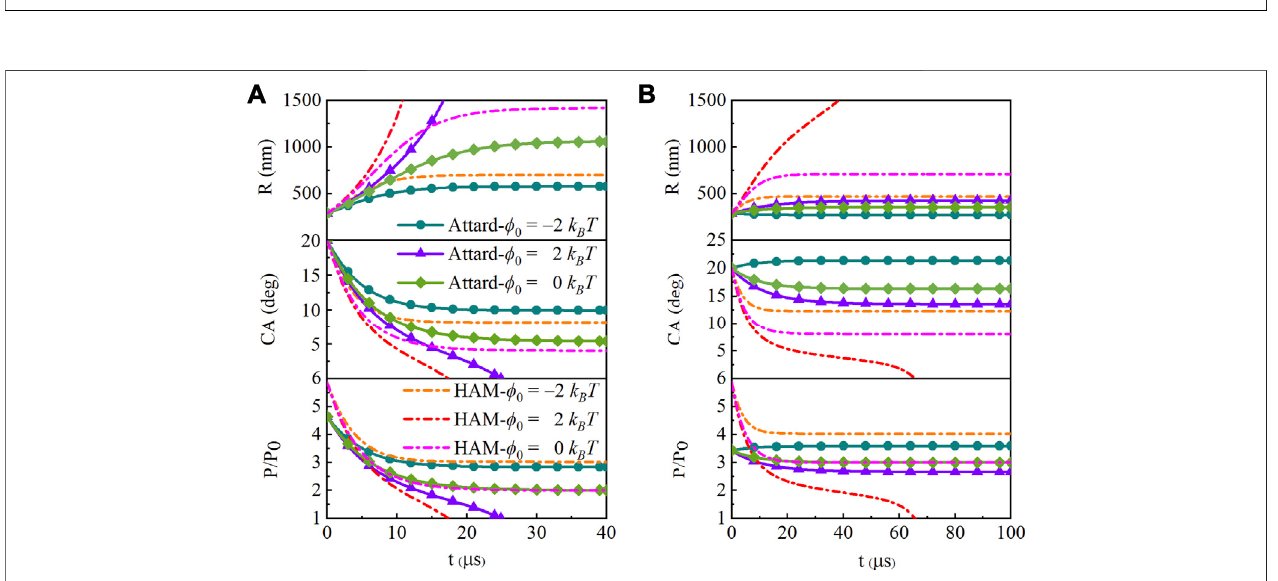
FIGURE 3 | Evolution of the curvature radius, contact angle (CA) and pressure with state-dependent surface tension at L (cid:1) 100 nm, initial contact angle θ 0 (cid:1) 20 o anddifferentsaturationratiosof (A) s (cid:1) 2, (B) s (cid:1) 3.Thecurvesareforhydrophobic( ϕ 0 (cid:1) − 2 k B T ,circlesymbol),hydrophilic( ϕ 0 (cid:1) 2 k B T ,trianglesymbol),andneutral( ϕ 0 (cid:1) 0 k B T , rhombus symbol) surfaces. The dashed ones are for hydrophobic attraction model (HAM) with the same surfaces.